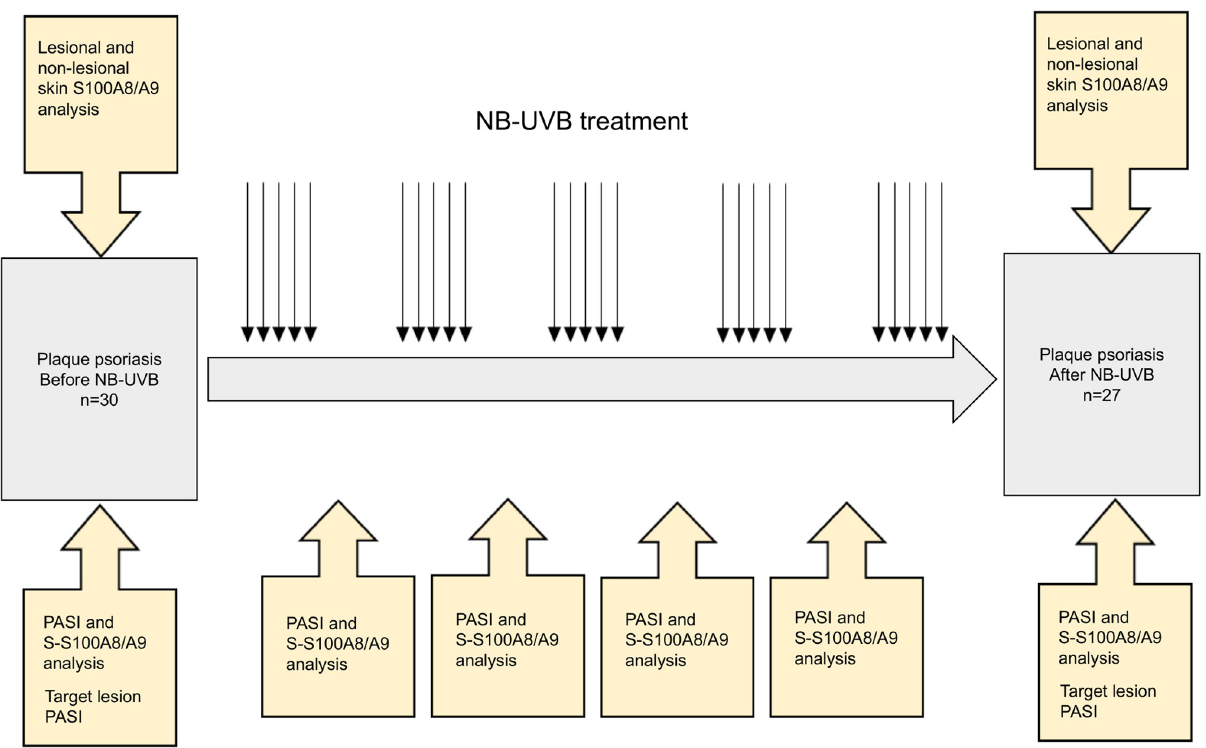
Fig 1. Schematic figure of the study protocol. Arrows represent NB-UVB treatment sessions.